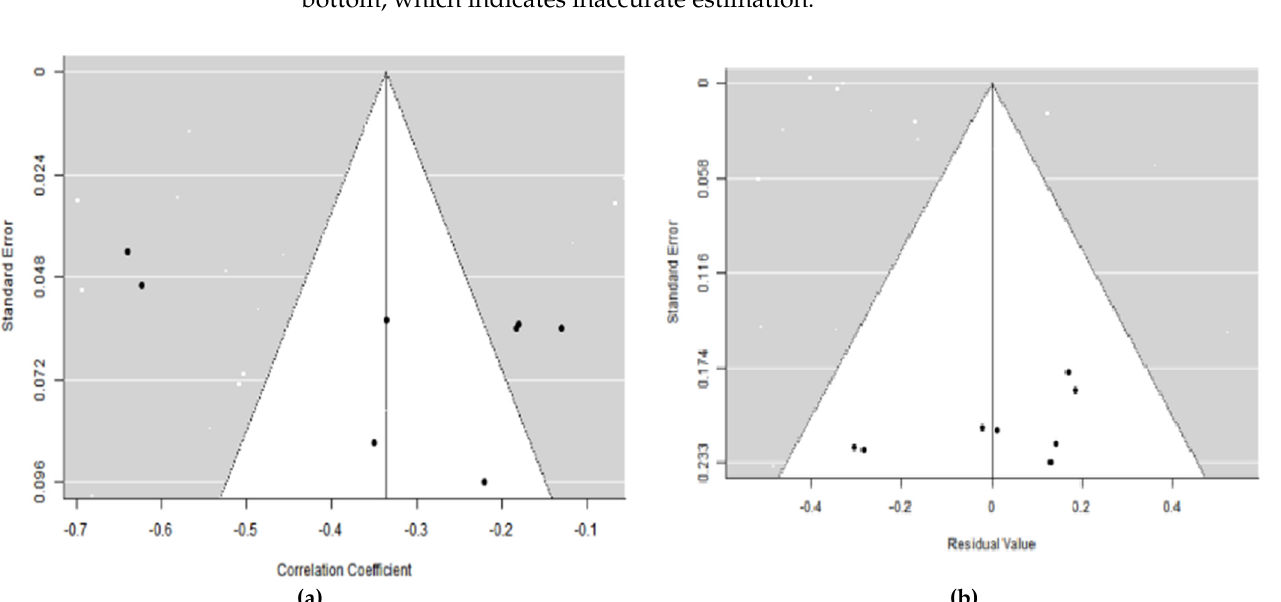
Table 3. b. Mixed effect of the study review.